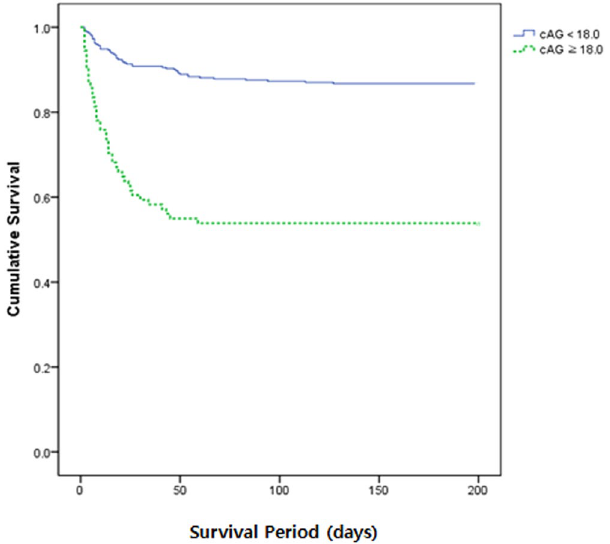
Figure 2. Survival curves for the patients according to cutoff value of corrected anion gap. The cutoff value of initial corrected anion gap was defined by 18.0 mEq/L ( p < 0.001 by log-rank